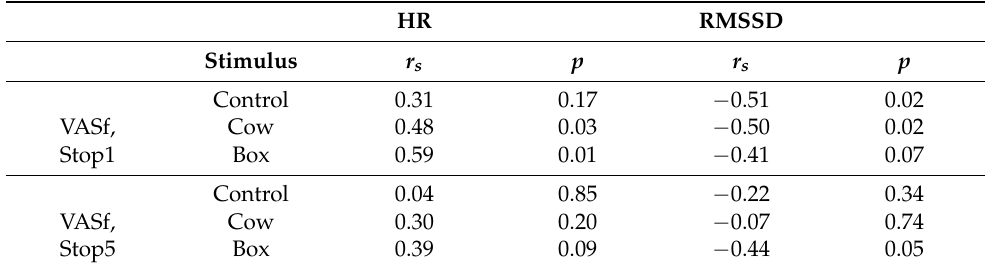
Table 6. Results from Spearman’s correlations between the experimenter’s rating of fearfulness (VASf) and physiological measures (HR–heart rate and RMSSD-root mean square of successive differences between heartbeats) at Stop1 and Stop5 during the hand-leading